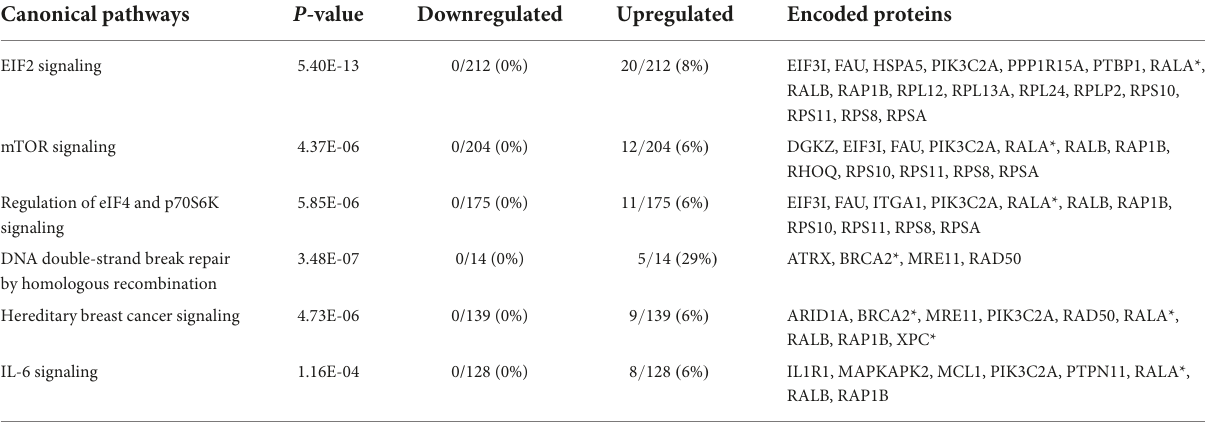
TABLE 2 Top canonical pathways enriched among the 244 common genes.